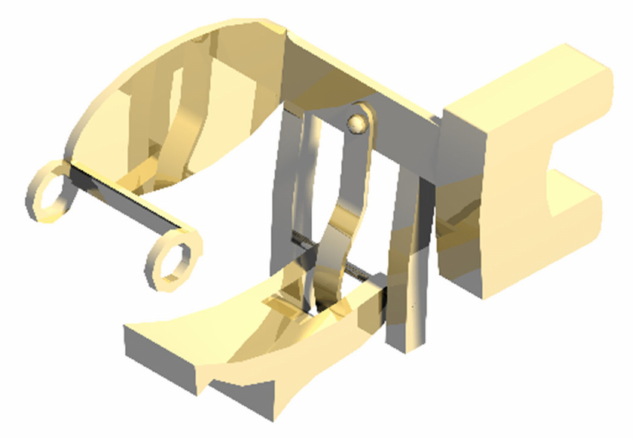
Figure 11. Carry mechanism.